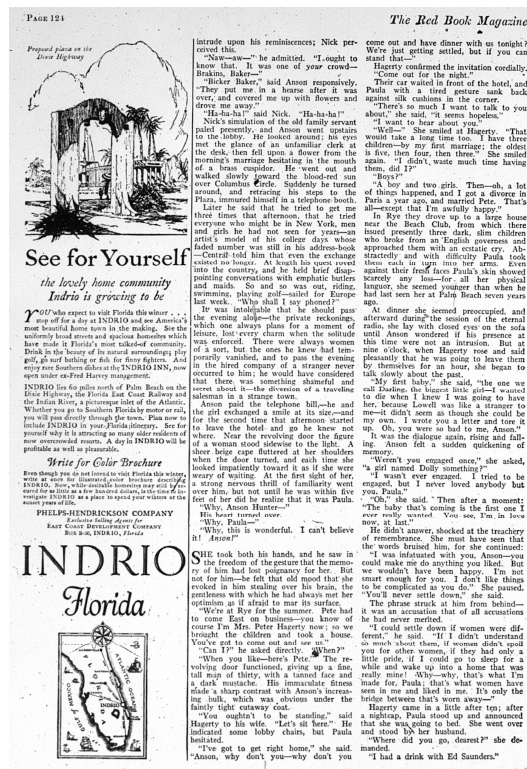
Figure 4. “The Rich Boy” as it first appeared in the February 1926 issue of Red Book Magazine (Fitzgerald 1926b), p. 124.